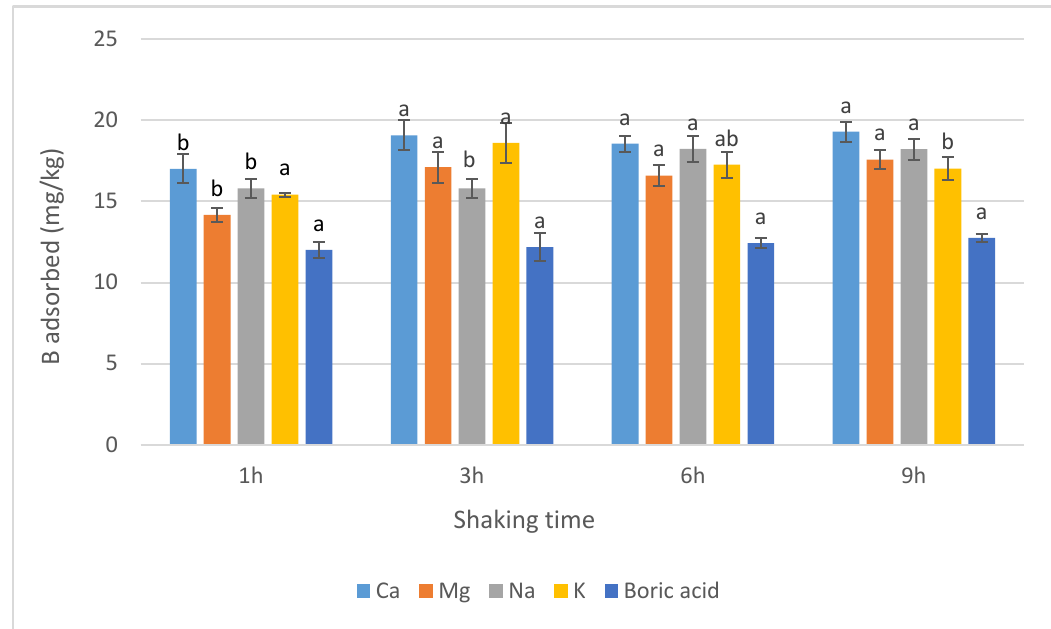
Fig.4: B adsorbed in Soil-B with different time of shaking in TBCa, TBMg, TBNa, TBK and TBo (Different letters indicate significant differences among the different time of shaking at P<0.05 level and at the same